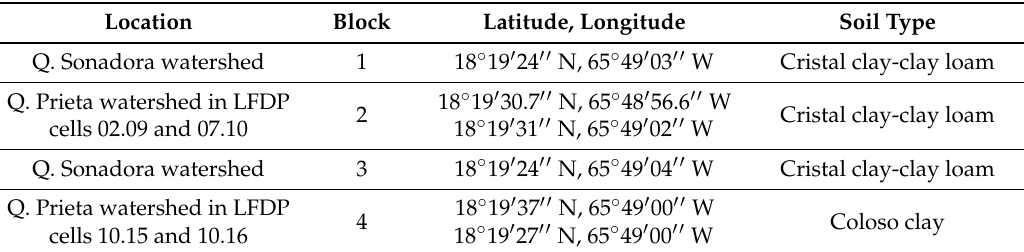
Table 1. Location of study blocks and their soil types in the El Verde Research Area of the Luquillo Experimental Forest.